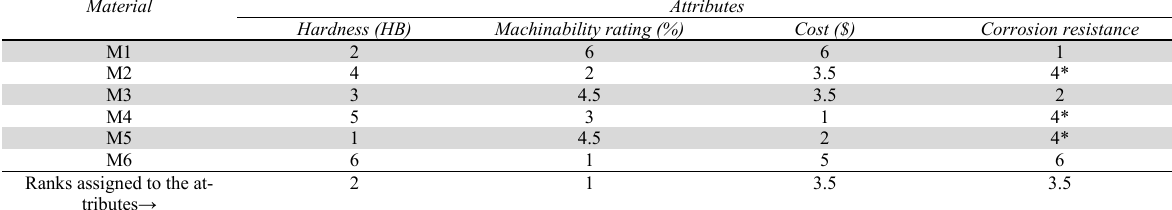
Ranks assigned to the alternatives and attributes of example